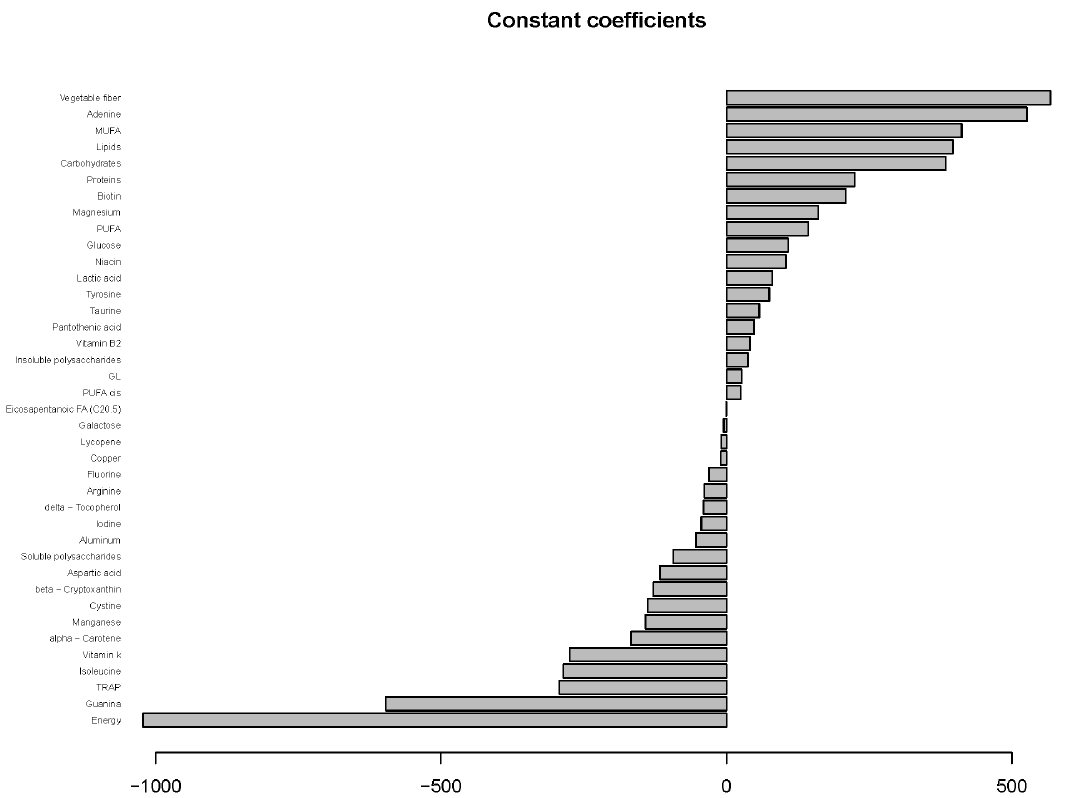
Figure 5. Constant coefficient estimates of the final model.